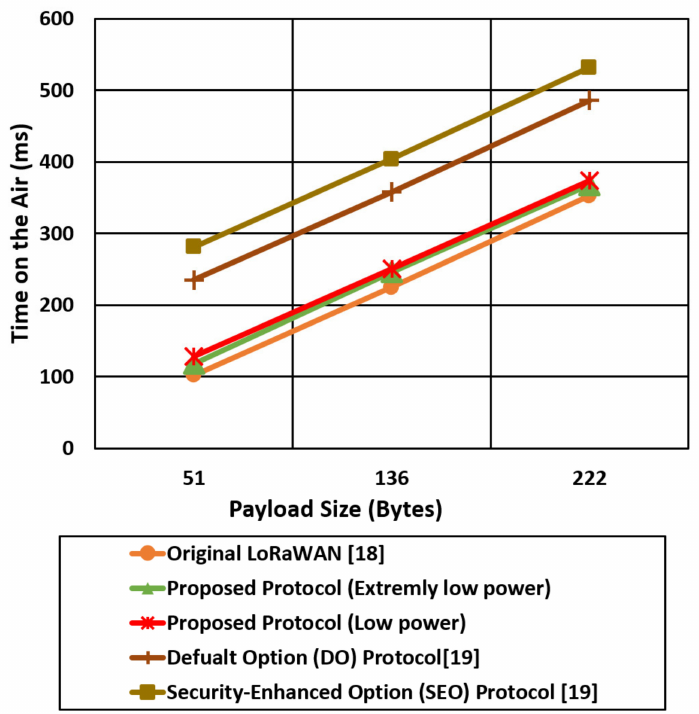
Figure 18. The time on the air comparison for the proposed protocol cases and the other mentioned LoRaWAN protocols using the best-case environment parameters (SF